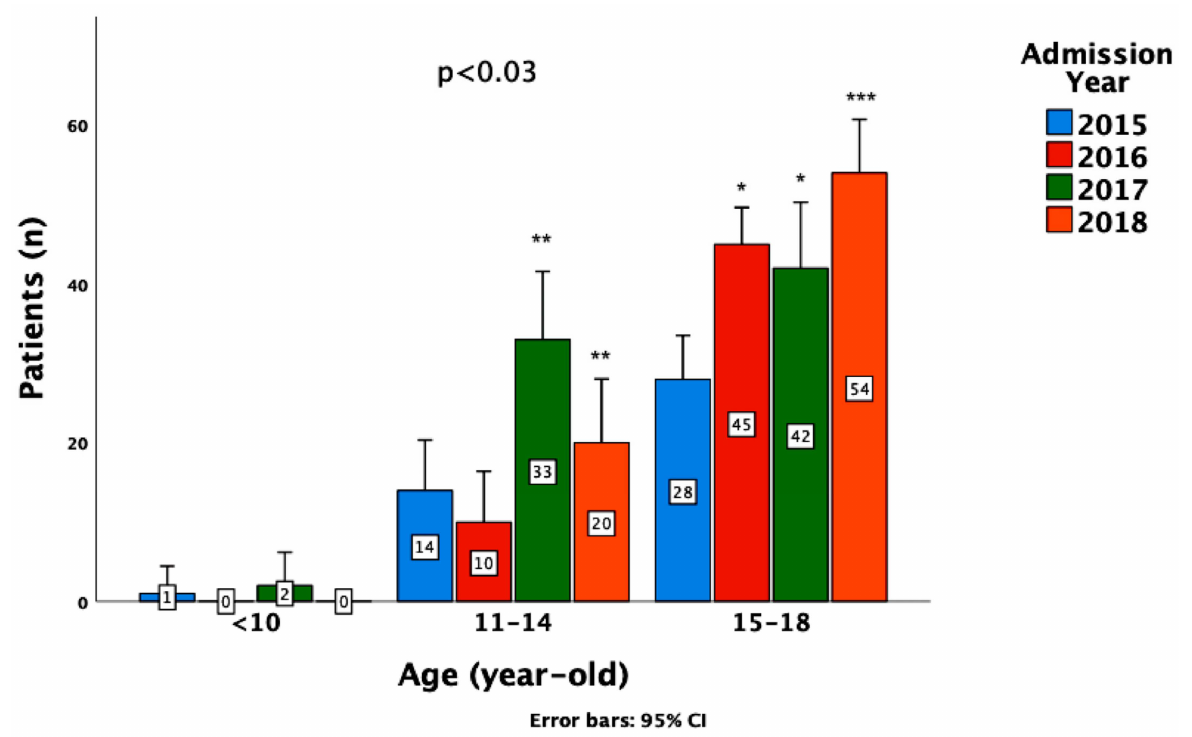
Figure 1. Longitudinal trends of admissions to the Pediatric Psychiatric Clinic per age group (ANOVA test, p < 0.03). Post hoc tests (Bonferroni, p < 0.05): Admission differences between * 2016 or 2017 vs. 2015; ** 2017 or 2018 vs. 2015 and 2016; *** 2018 vs. 2015, 2016, and 2017. The reasons for admission to the PPC varied by sex ( p < 0.001), with more than half of girls admitted for attempted suicide (26.5%) or suicidal behavior (32%), and most boys admitted for behavioral disorders (31%) and psychosis (22%) (Figure 2).